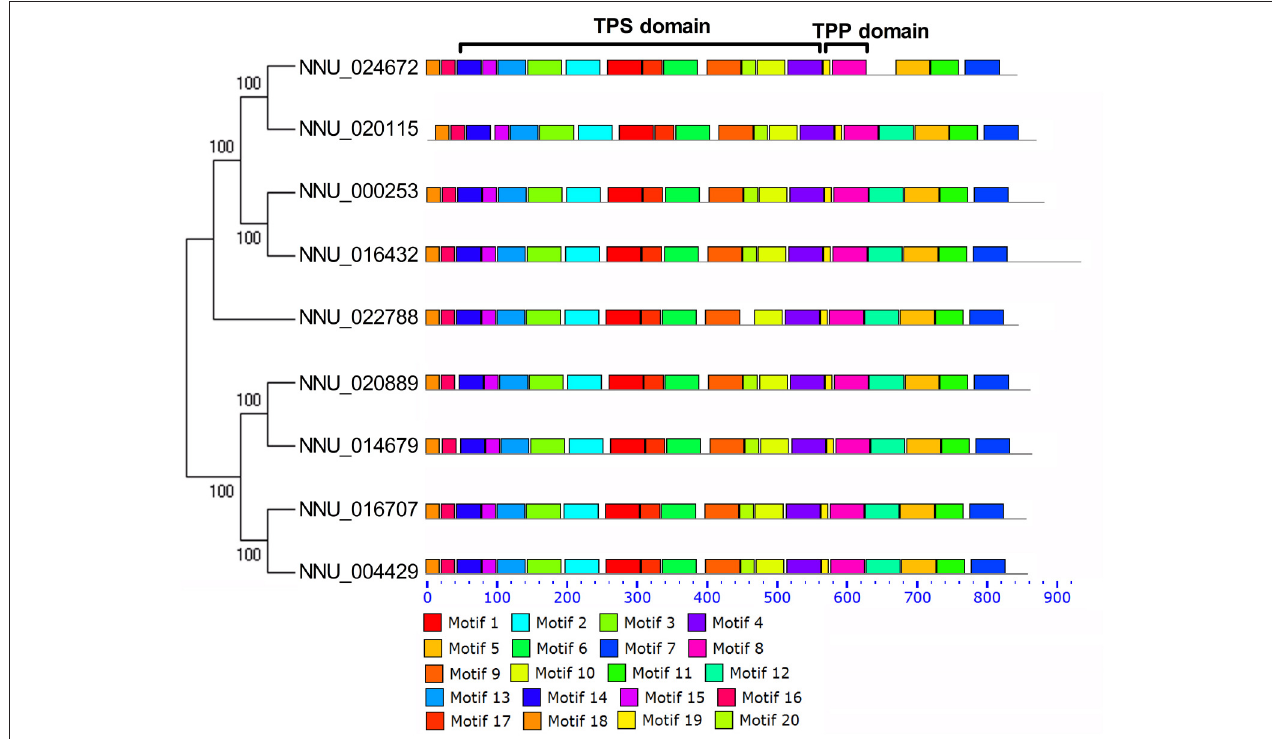
FIGURE 3 | Schematic diagram of amino acid motifs of TPS protein. Motif analysis was performed using MEME 4.11.2 as described in the methods. The different-colored boxes represent different motifs and their position in each TPS sequence. The sequences of key motifs that located in TPS and TPP domain were